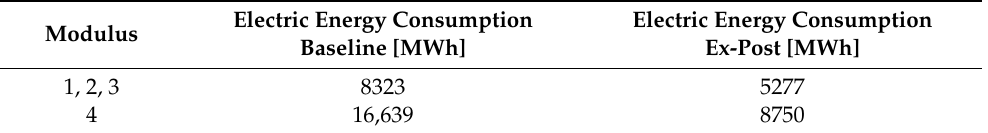
Table 2. Electric energy consumption during a year in baseline and ex-post configurations for moduli Table 2 . Electric energy consumption during a year in baseline and ex-post con fi gurations for mod- 1, 2, 3, and uli 1, 2, 3, and 4.